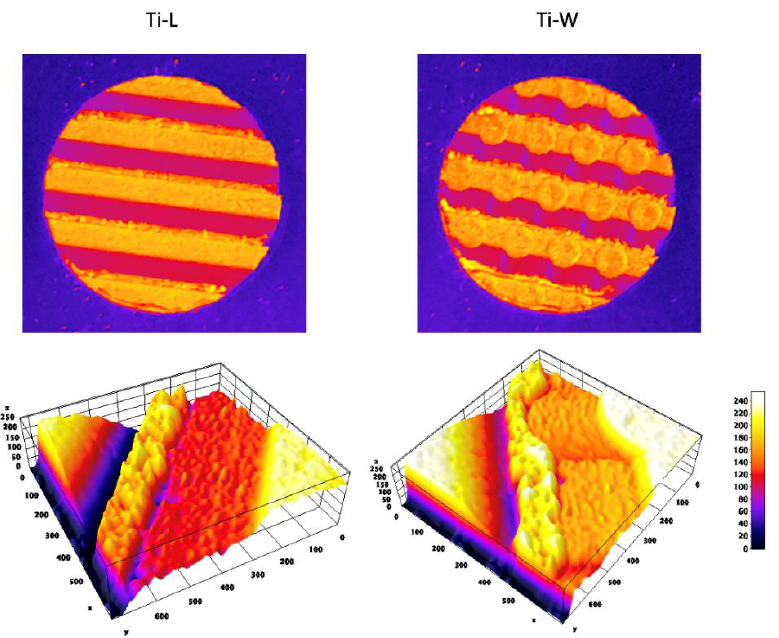
Figure 3. Macroscopical and microscopical 3D reconstruction Ti-M and Ti-S discs. The macroscopical and microscopical 3D reconstructions were obtained using ImageJ Software, starting from a photograph of the discs and SEM images at 295×, respectively.